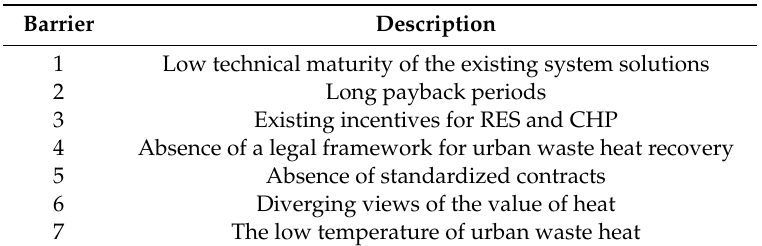
Table 2. Barriers to urban waste heat recovery investments.